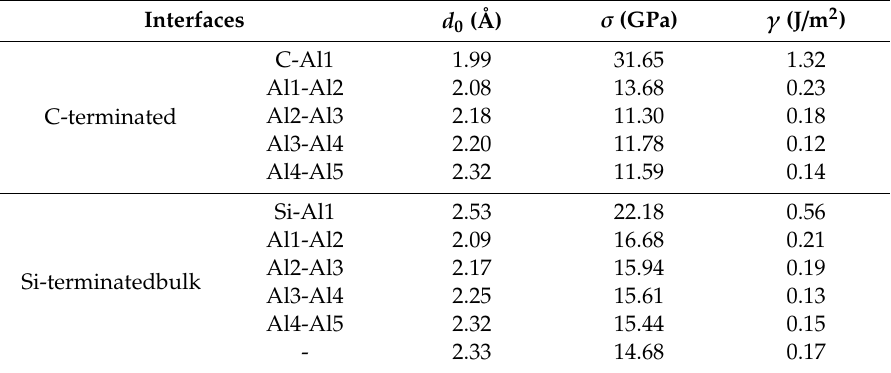
Figure 4. The stress–displacement curves of the C-terminated ( a ) and Si-terminated ( b ) Al (111)/6H-SiC (0001) interfaces. C-Al1 represents the cleavage plane between C and Al1 atomic layers, as shown in Figure 2. The same is true of other situations. For comparison, the stress–displacement curve of the bulk Al is also shown here. Table 2. Equilibrium interfacial distance ( d 0 ), ideal tensile strength ( σ ) and generalized stacking fault energy ( γ ) at di ff erent cleavage planes. C-Al1 is expressed as the cleavage plane between C and Al1 atomic layers in Figure 1. The same is true of other